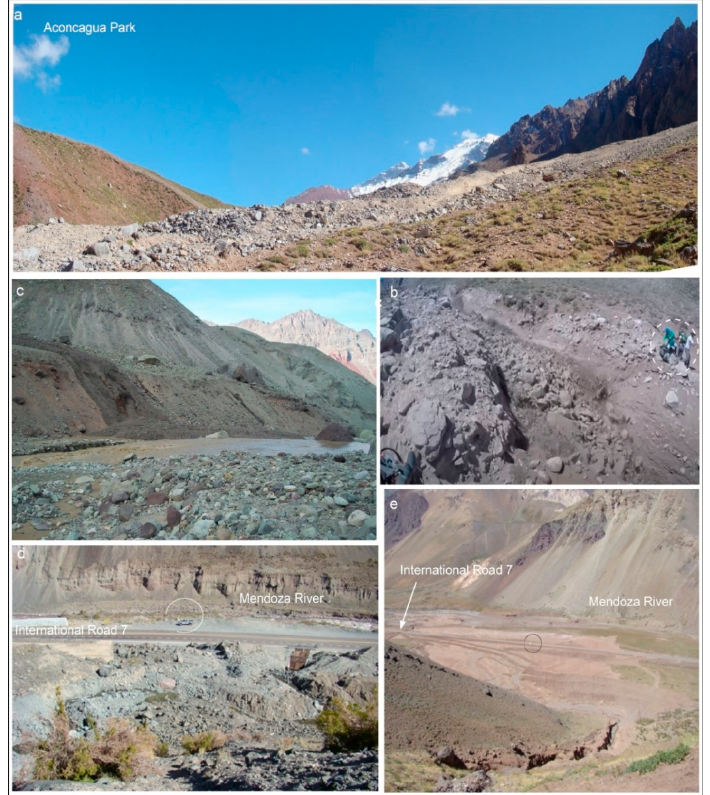
Figure 8. Events triggered by snow or glacial ice melting in Mendoza Valley (32°50 ′ S) ( a ) Ridges of historical DFs channeled in the alluvial fan of the Blanco creek (Aconcagua Park) [94]; ( b ) the DF occurred in January 2016 when tourists were crossing the Blanco creek [93]; ( c ) DF generated from an ice-core moraine in the Vieja Alta Creek near the Plaza Guanacos camp in February 2004 [104]; ( d ) DFs generated from a debris-rock glacier melting in the Negro creek on 28–29 December 2015 with an estimated volume of 30,018 m 3 [12], the circle pointed out with a car; and ( e ) DFs caused by the melting of a debris-rock glacier in La Salada creek (Mendoza Valley 32 ◦ 50 (cid:48) S) with an estimated volume of 238,891 m 3 [12], circle corresponds to a